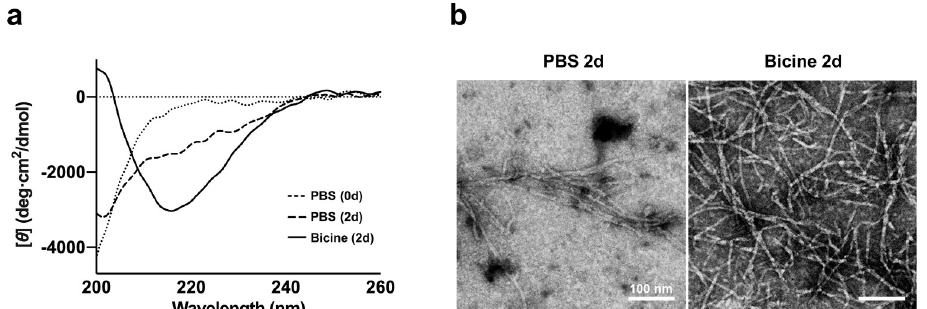
Fig 2. Analysis of A β (1–40) peptides in bicine and PBS via (a) structural analysis by CD spectra and (b) TEM imaging. ( a ) A β (1–40) (25 μ M) peptides were dissolved and incubated in bicine (20 mM) for 2 days or PBS (1X) for 0 and 2 days. ( b ) A β (1 − 40) (50 μ M) incubated for 2 days in bicine (20 mM) and PBS. TEM imagery scale bar indicates 100 nm of size. These experiments were performed in triplicate independently. CD: circular dichroism, TEM: transmission electron microscopy, d: day.